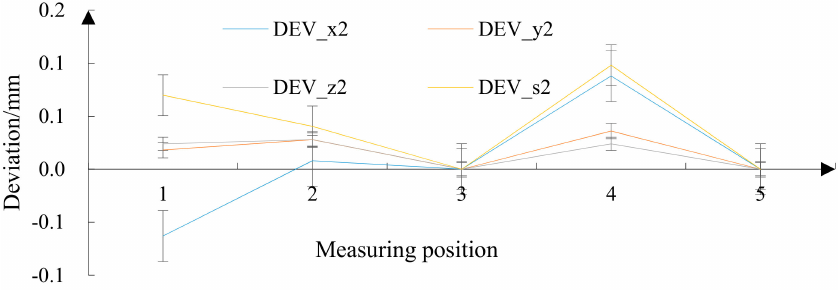
Figure 16. Relative deviation under the trajectory optimization algorithm.